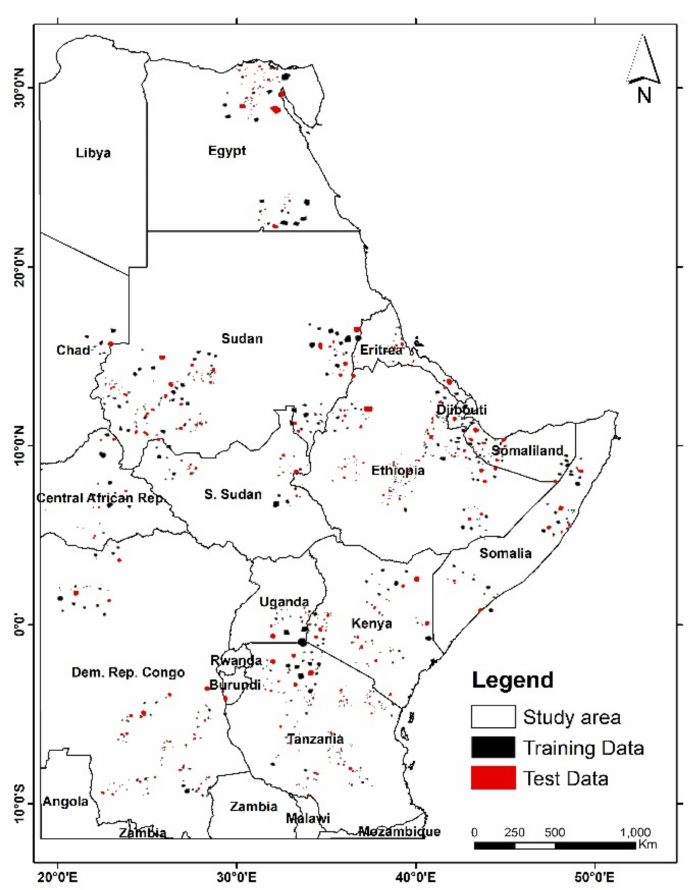
Figure 3. Distribution of reference data in the study